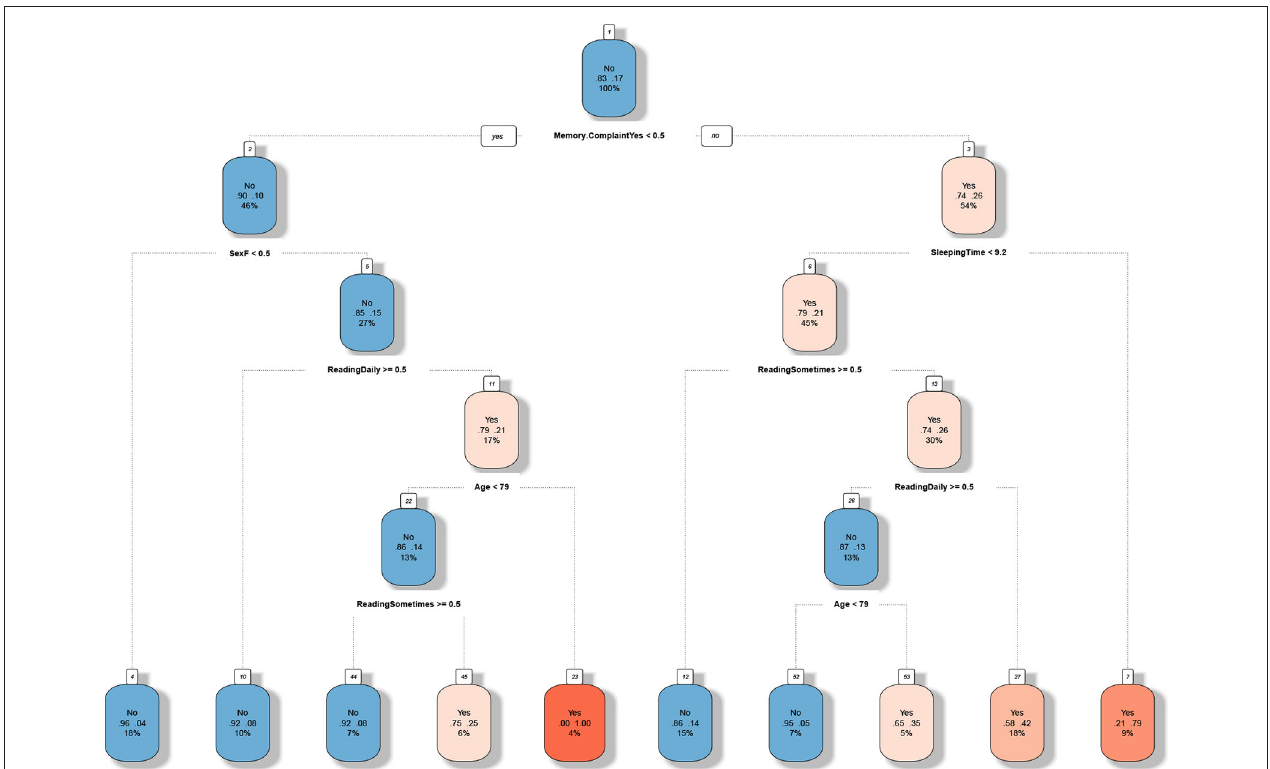
FIGURE 2 | Tree developed with a recursive partitioning algorithm using a training set. For every box, the first line is whether or not the user is classified to be in risk of MCI. The second line consists in two numbers, which indicates the estimated probability of being positive in MCI. The last line in the box is the percentage of the data fulfilling these conditions. The text below the box is the question corresponding to the next split. The warmer is the color of the box, the more likely is a user in that node to be positive in MCI.